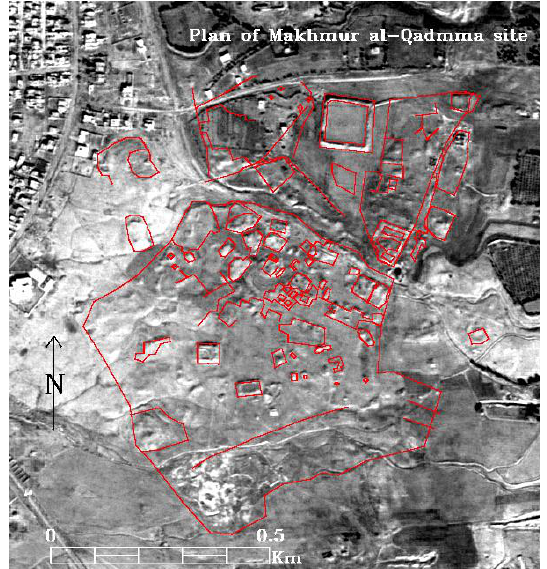
Figure 2 - Plan of Makhmúr al-Qadíma archaeological site based on FORMOSAT-2 band 1